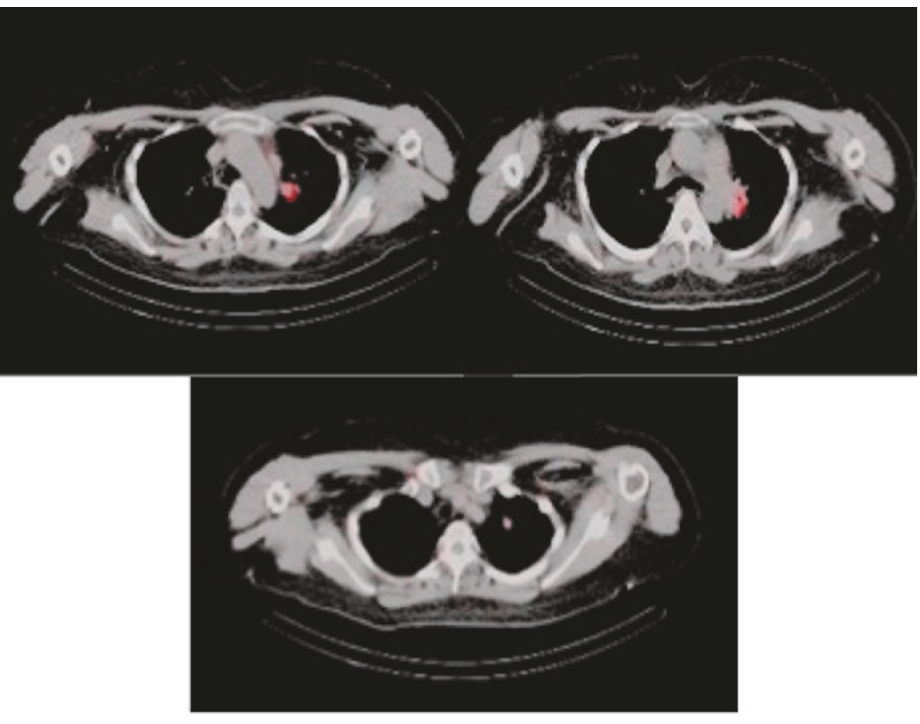
Figure 6: Positron emission tomography/commuted tomography showing 2 left upper lobe lung masses.